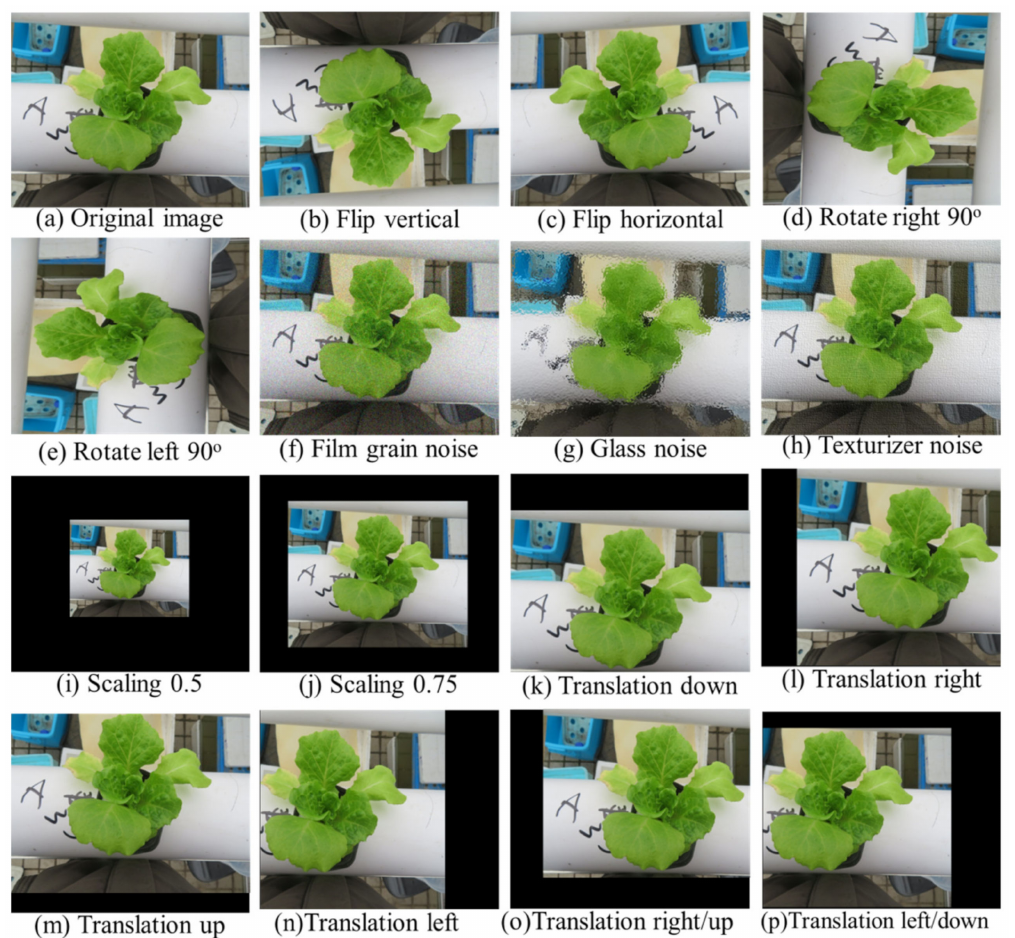
Figure 4. Example images after applying data augmentation protocols: ( a ) Original image ( b ) Flip vertical ( c ) Flip horizontal ( d ) Rotate right 90 o ( e ) Rotate left 90 o ( f ) Film grain noise ( g ) Glass noise ( h ) Texturizer noise ( i ) Scaling 0.5 ( j ) Scaling 0.75 ( k ) Translation down ( l ) Translation right ( m ) Translation up ( n )Translation left ( o )Translation right/up ( p )Translation